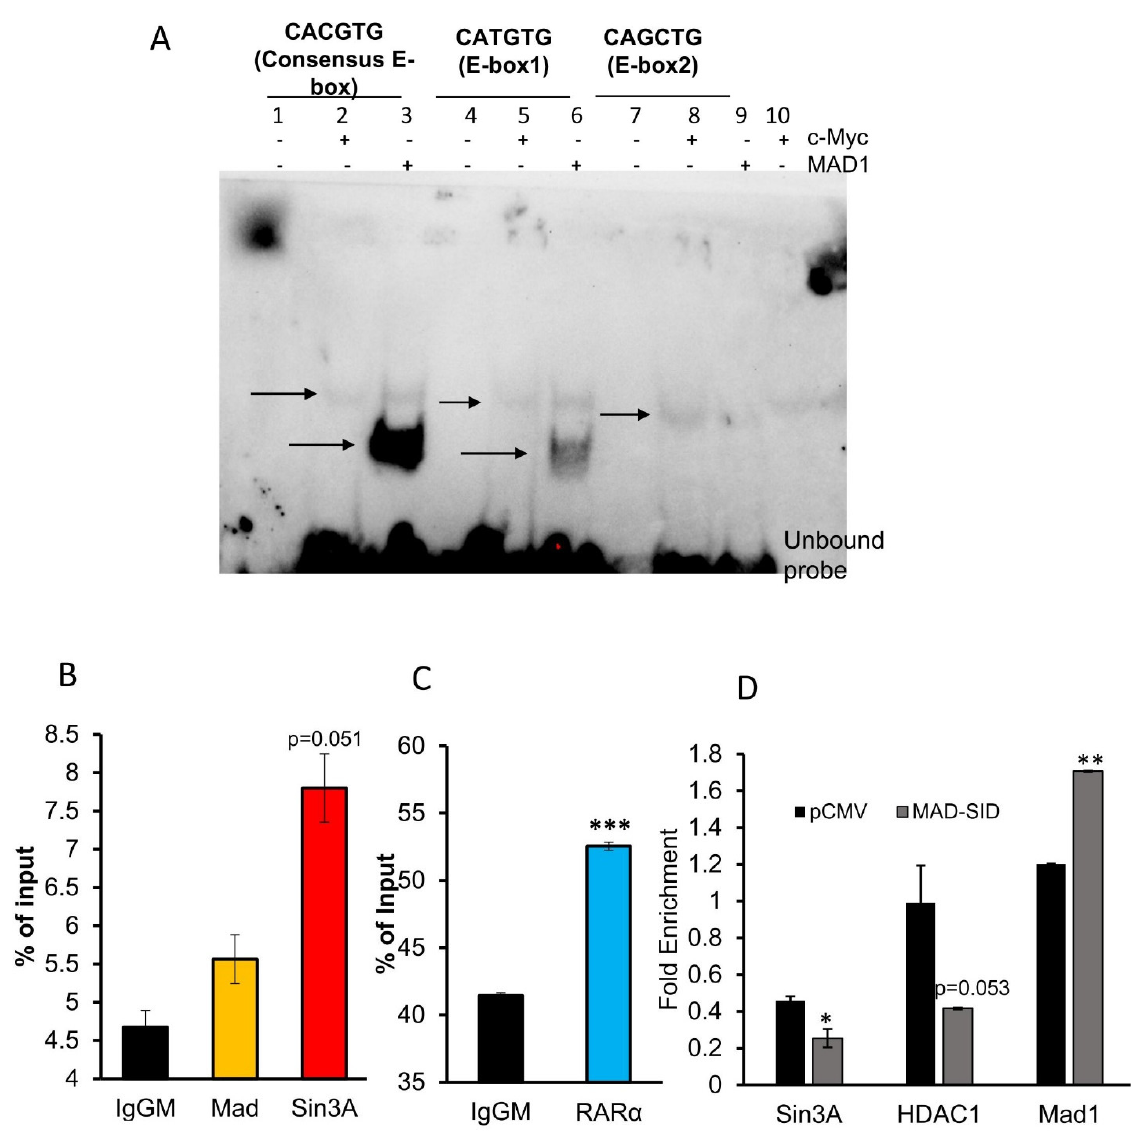
Figure 3. MAD-Sin3A Complex members are present at the RAR β promoter: ( A ) The Electrophoretic Mobility Shift Assay showed that Mad binds to the proximal E-Box of the RAR β promoter. Arrows indicate the shift in the movement of probes resulting from c-Myc (lanes 2,5,8) or MAD1-binding (lanes 3,6,9). The blot presented is a representative figure of four independent experiments. ( B , C ) The Chromatin immunoprecipitation Assay performed on the RAR β promoter of MDA-MB 231 cells showed the enrichment of Sin3A and MAD1 on the E-box and RAR α on the RARE sequence of the RAR β promoter. The data presented are an average of three independent experiments. ( D ) The MAD-SID-overexpressing cells showed a reduced enrichment of Sin3A and HDAC1 on the